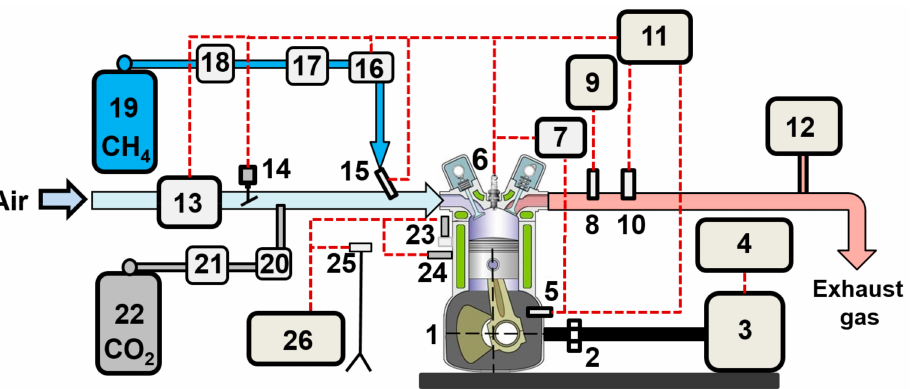
Figure 1. Experimental setup. 1—HR16DE SI engine; 2—connecting shaft; 3—engine load